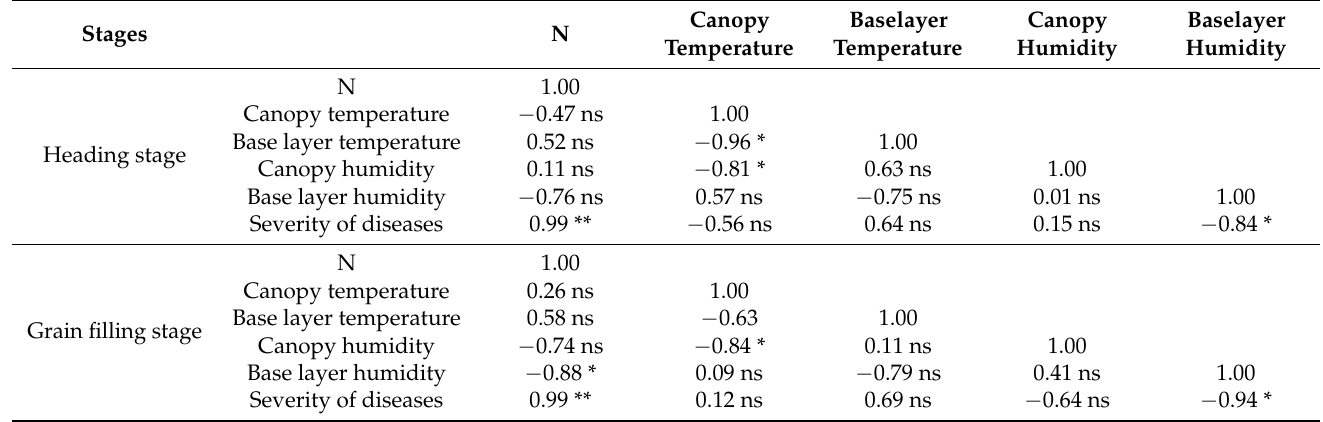
Table 3. Correlation Analysis among N application rate, population temperature, humidity, and sheath blight.